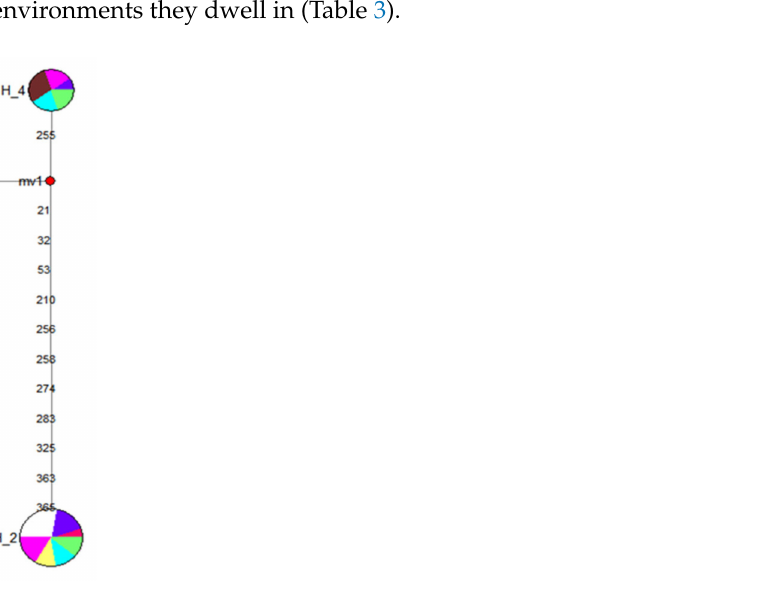
Figure 3. Median-Joining network of native Ethiopian horses (Abyssinian = Red; Bale = Blue; Boran = White; Horro = Pink; Kafa = Yellow; Kundido = Black; Ogaden = Magenta; and Selale = Green). Circles are proportional to the frequency of individual haplotypes. Median vector is indicated in red. Numbers indicate the number of mutation steps between haplotypes. Table 3. Horse populations, sample sizes (n), number of polymorphic sites (S), haplotypes per population (Hp), haplotype diversity (Hd), nucleotide diversity ( π ) (Nei, 1987) and average number of nucleotide differences ( K ) and their standard deviations in native Ethiopian horse